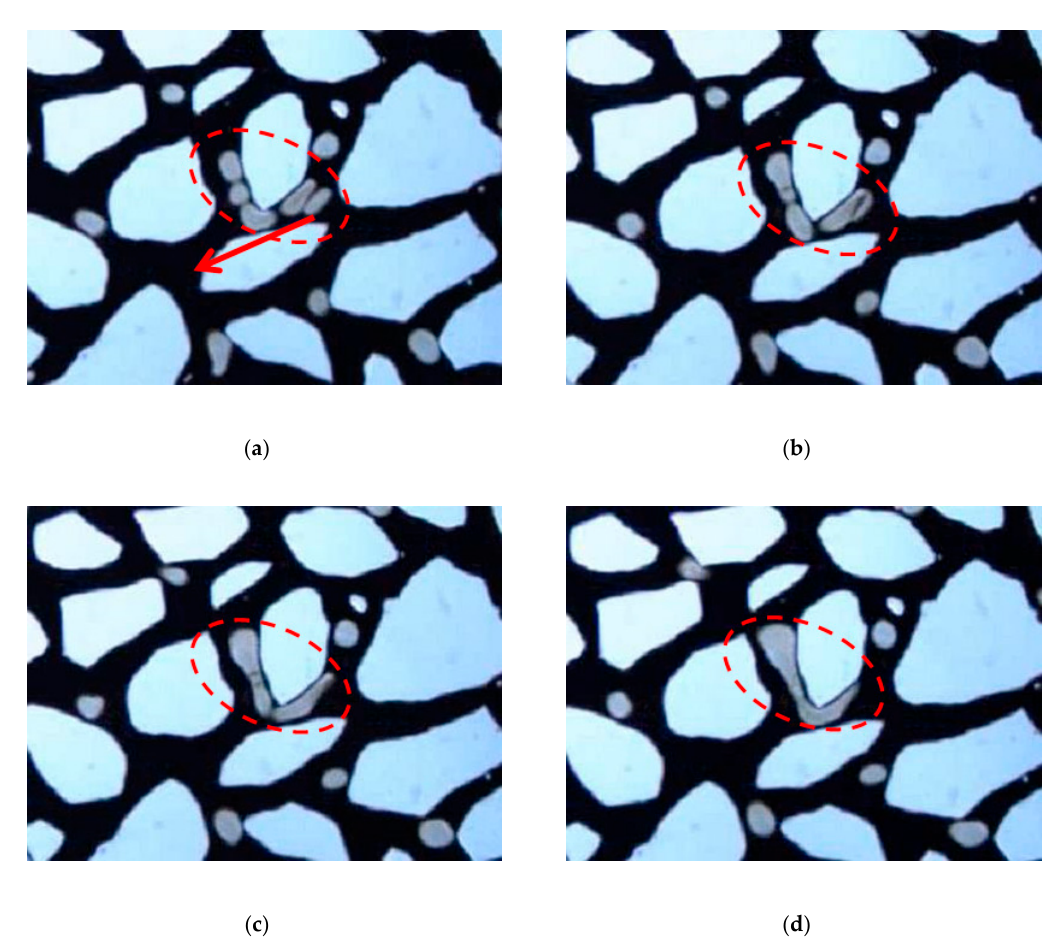
Figure 11. A continuous process whereby bubbles coalesce: ( a ) bubbles come across; ( b – d ) bubbles coalesce.